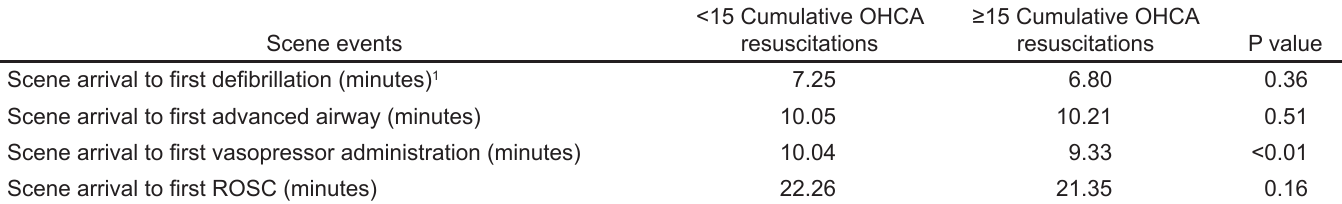
Table 4. Comparison of scene events by paramedic 5-year out-of-hospital cardiac arrest (OHCA) case volume experience.